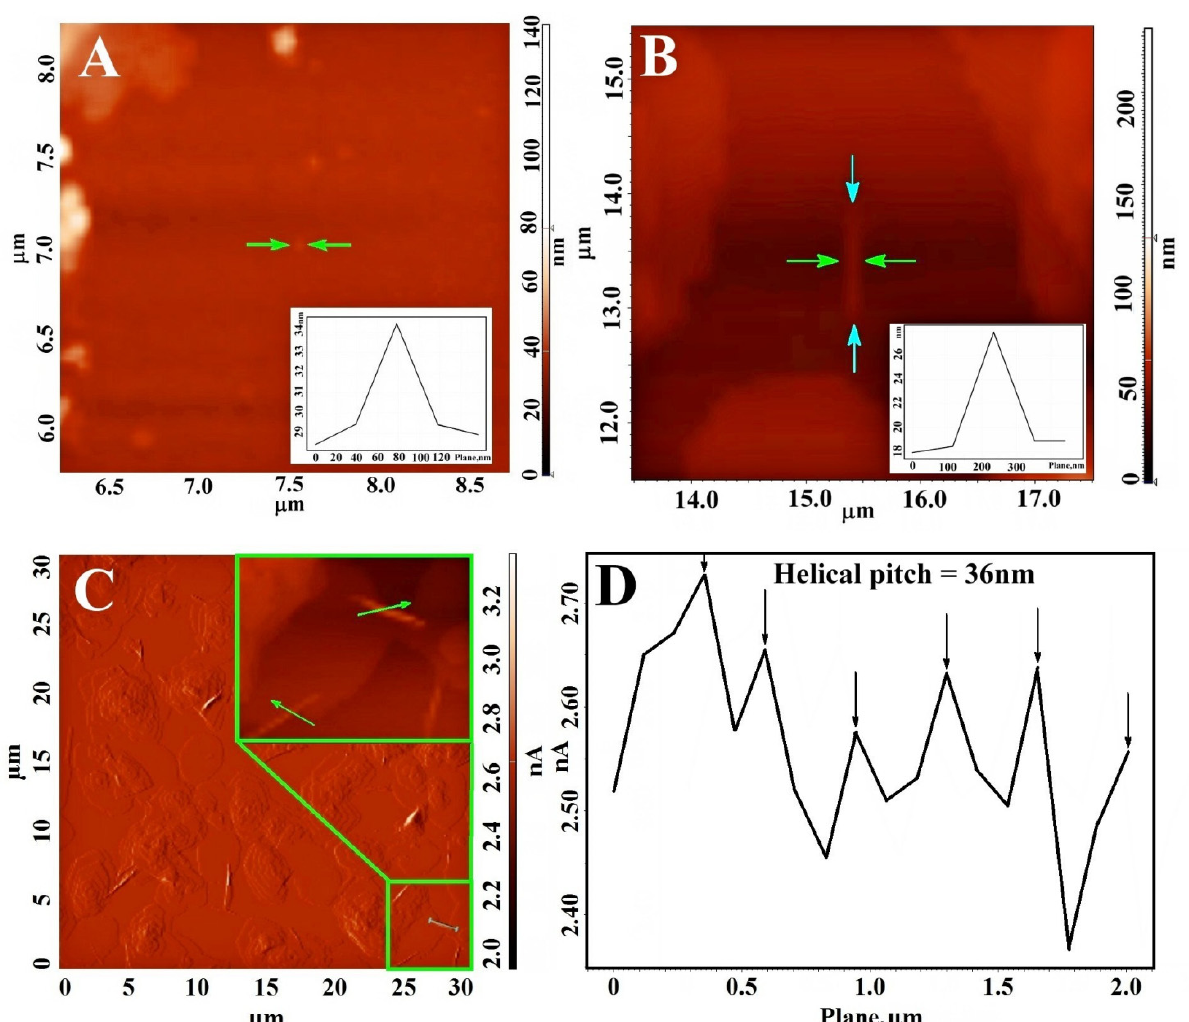
Figure 4. ( A ) AFM height image of round-shaped-like particles formed in the thin film of EDOT-PCL , obtained from its ACN solution—the inset shows a cross-sectional analysis of the particle’s horizontal line and marked by arrows); ( B ) AFM height image of a straight rod with the length marked by the blue arrows—the inset shows a cross-sectional analysis of the rod’s horizontal line and is marked by the green arrows; ( C ) AFM amplitude image evidencing the formation of the helical rods—the inset is the magnified marked area showing a high aspect ratio of helical rods with the arrows indicating both left- and right-handedness; ( D ) cross-sectional analysis that provides an average value of the helical pitch.